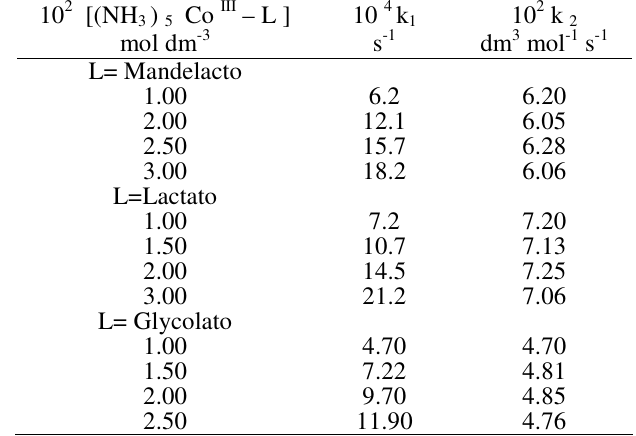
Table 5. First order values of the concentration of cobalt (III) bound α -hydroxy acids in CTAB. [H O ] = 2.00 x 10 -3 mol dm -3 ,[ H 2 2 Temperature = 35 ± 0.2 0